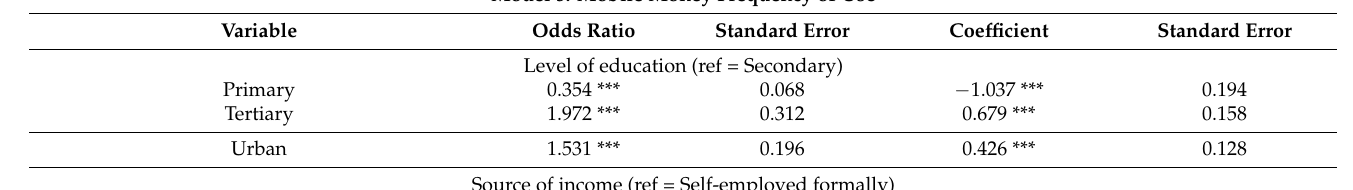
Table 5. Cont. Model 5: Mobile Money Frequency of